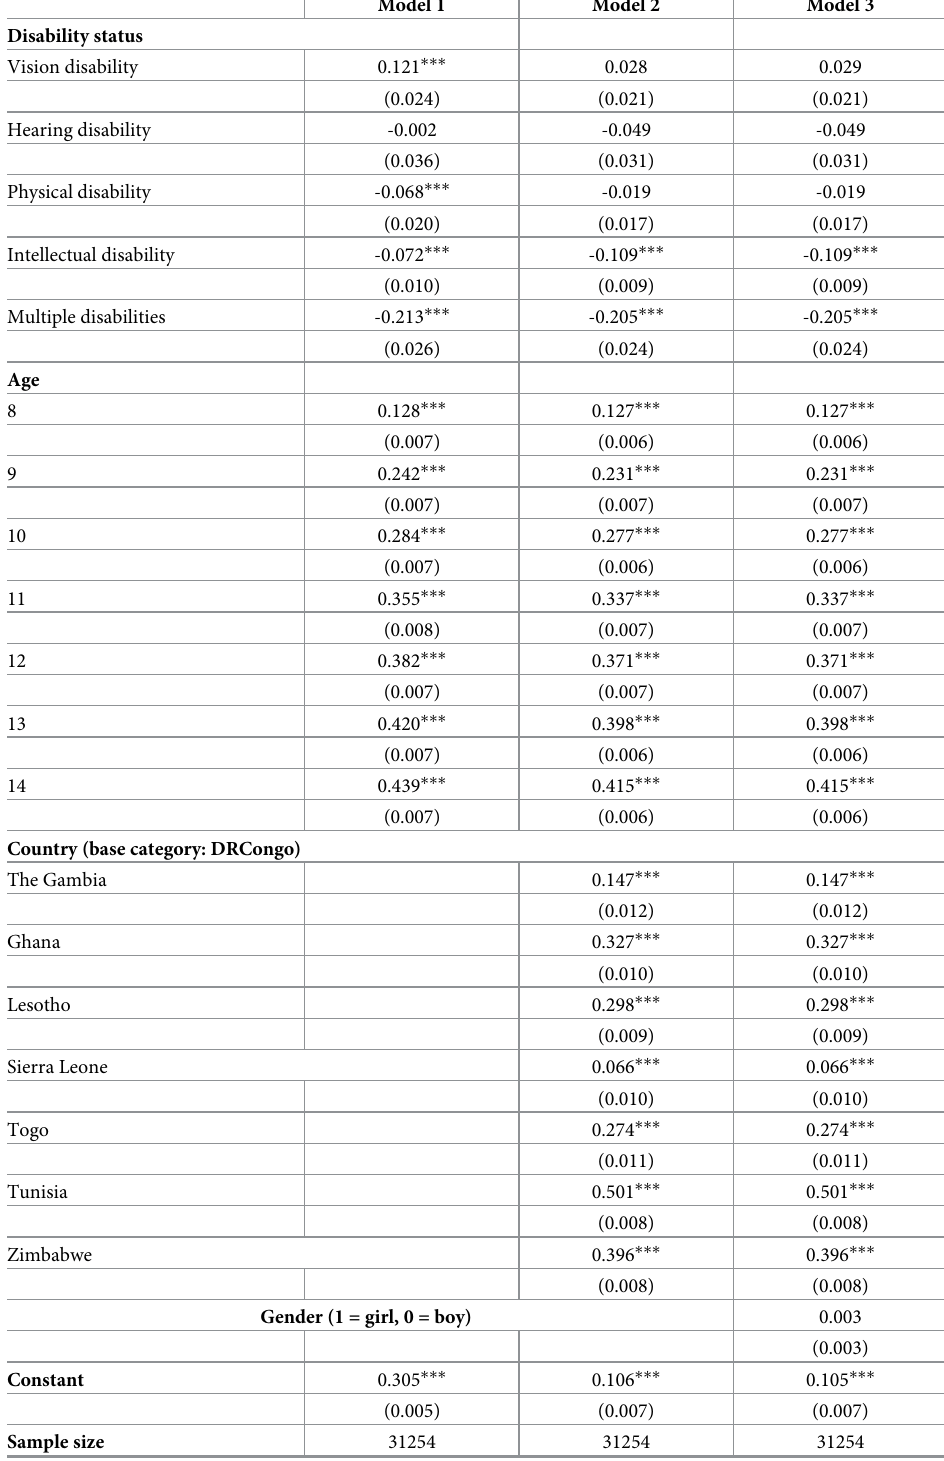
Table 3. Regression results for disability effects on the mean numeracy test